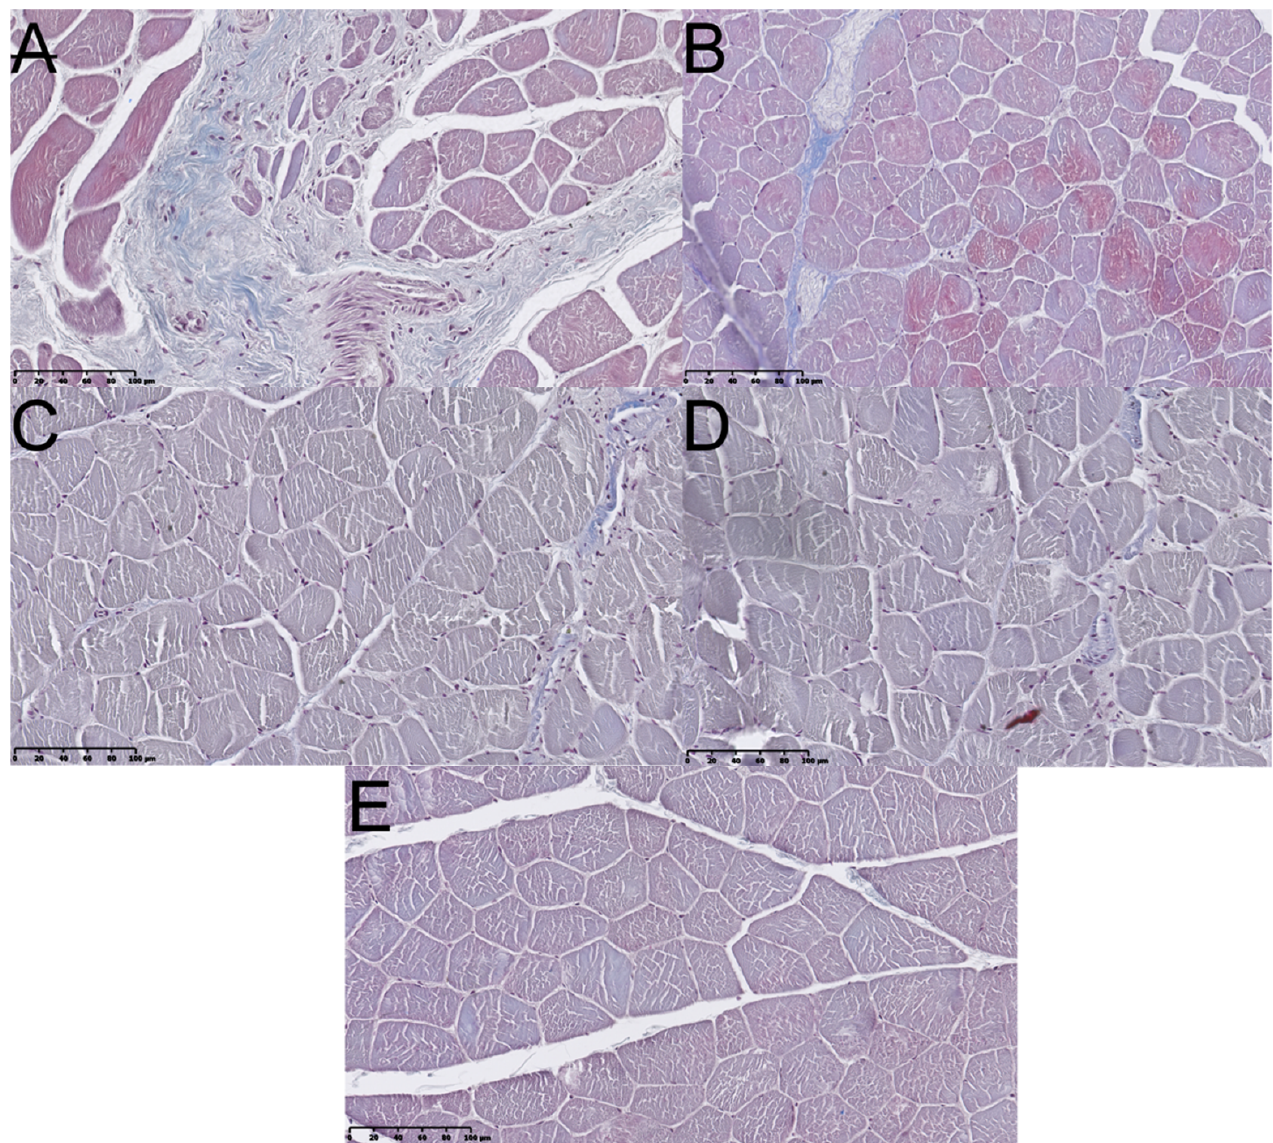
Figure 8. Masson’s Trichrom stained images of gastrocnemius muscle sections from the operated limb ( A – D ) and from random unoperated limb ( E ). ( A ) In the nerve gap group, an increased fibrotic tissue prevalence is present. ( B ) Autograft group—relatively low level of fibrosis within muscle bundles or their peripheral surrounding. ( C ) P(LLA-CL)-COL-PANI conduit group—image is comparable with group B. ( D ) P(LLA-CL)-COL-PANI conduit with ASCs group—image is comparable with group B and C. ( E ) Histologic image of a correct, unaffected muscle. Scale bar 100 µ